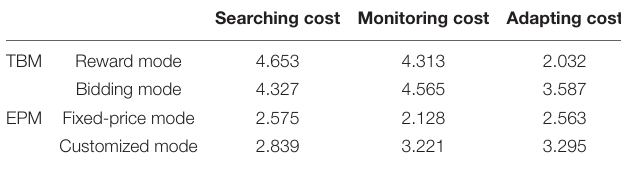
TABLE 2 | Mean value of transaction cost in different markets of survey